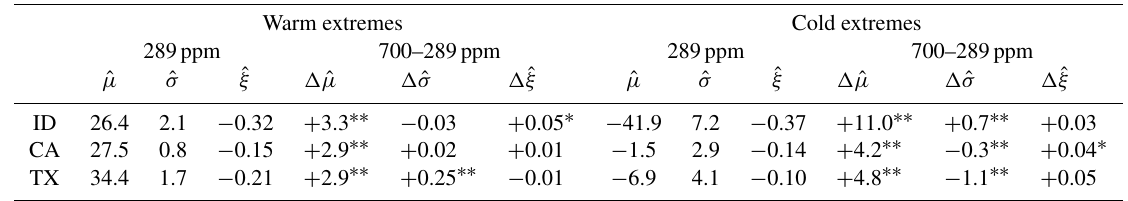
Table 1. GEV parameter estimates of warm and cold extremes for pre-industrial climate state and the estimated changes from pre-industrial to 700ppm climate state at ID, CA, and TX